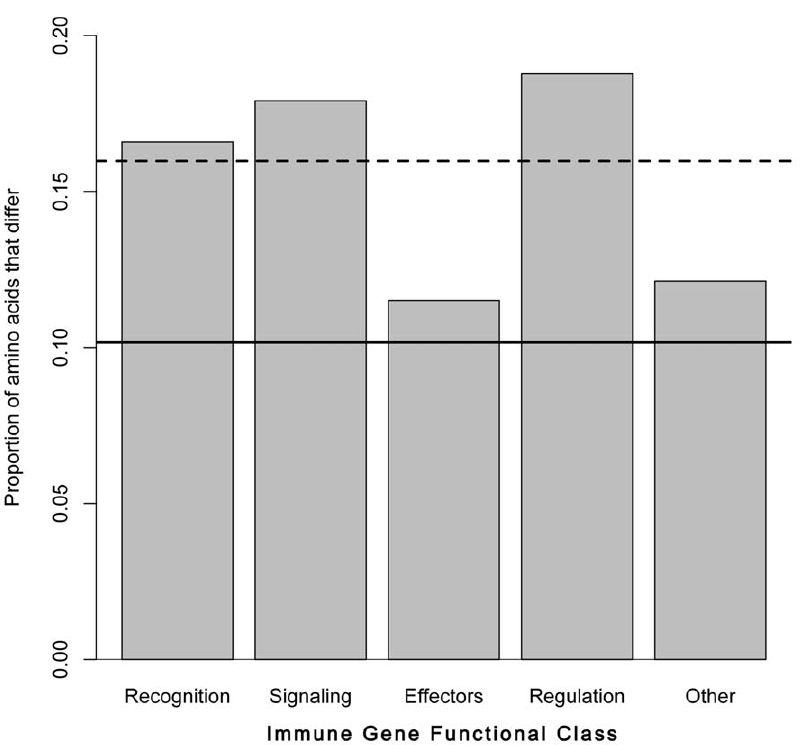
Figure 4. Variation in transcript divergence among immune gene functional classes. Protein sequence divergence was estimated as the proportion of aligned amino acids that differ between 1:1 An. funestus : An. gambiae orthologues. As a class, immune gene orthologous pairs (dotted line indicates mean divergence between immune gene orthologues) are significantly more diverged than the transcriptome as a whole (solid line indicates mean divergence across the entire transcriptome; p- value=4.8 6 10 2 5 , Mann-Whitney U-test). The functional classes within the immune genes are not significantly different from each ( p- values . 0.05, pairwise Mann-Whitney U-tests).